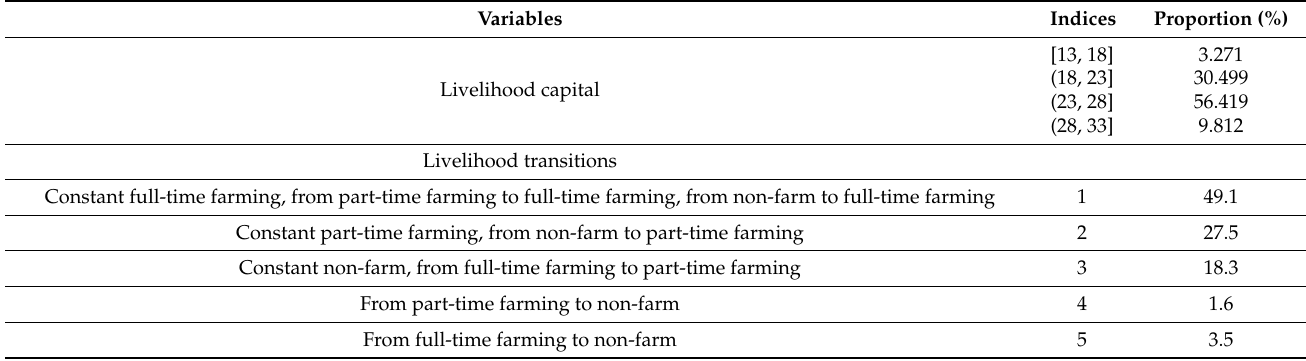
Table 4. Classifications of rural livelihood capital and livelihood